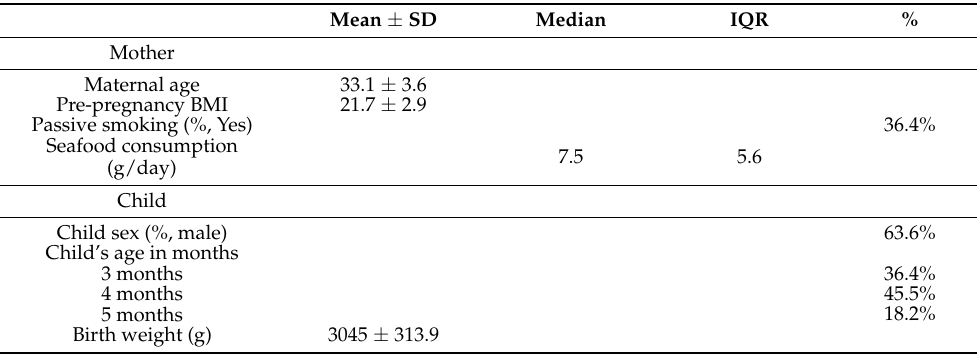
Table 1. Characteristics of the participants